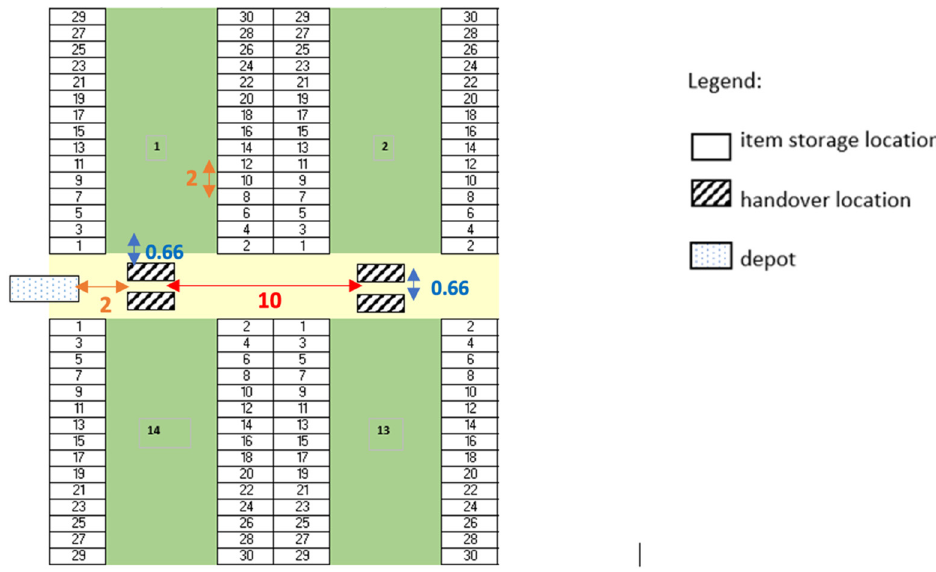
Figure 4. Distances in the two-blocks layout with separated handover locations (meters).